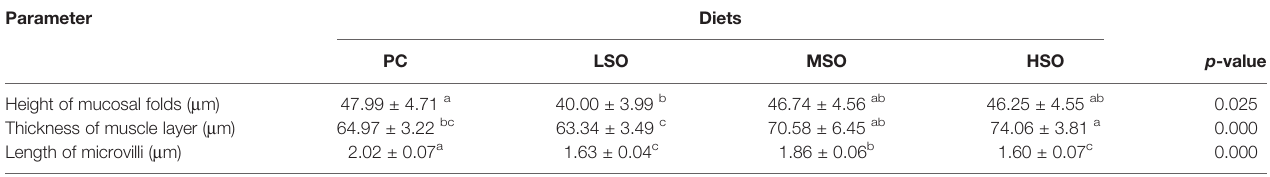
TABLE 7 | Mid-intestinal morphology parameters of shrimp in this study.